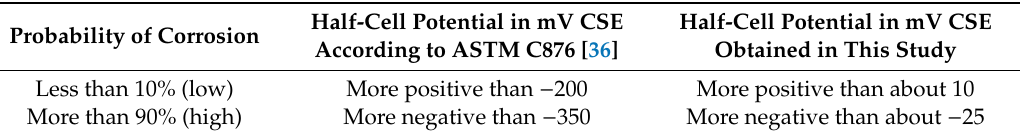
Table 4. Comparison of electrochemical potential in relation to corrosion probability based on ASTM C876 [36] and statistical analysis in this study.